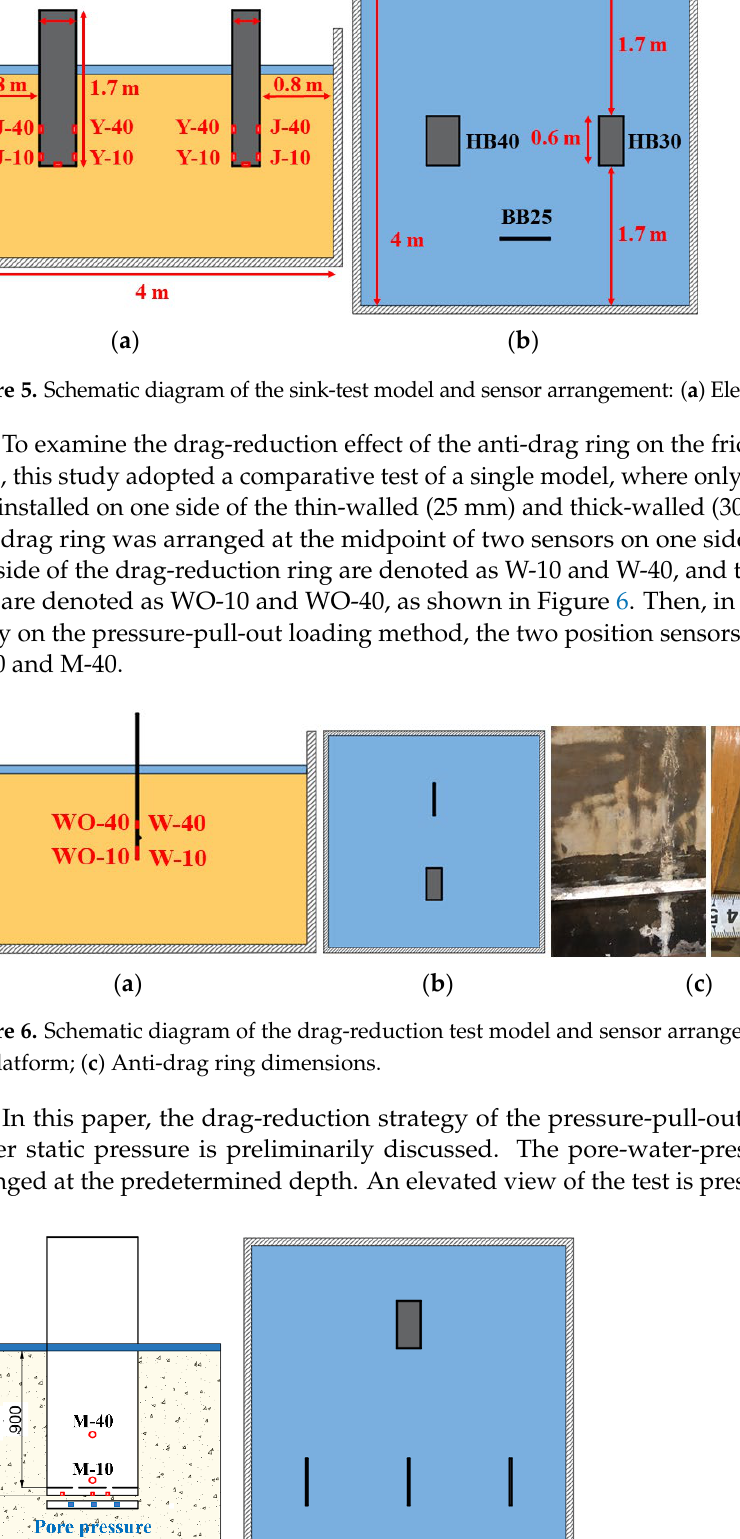
Figure 7. Schematic diagram of the BB25 model and sensor arrangement.